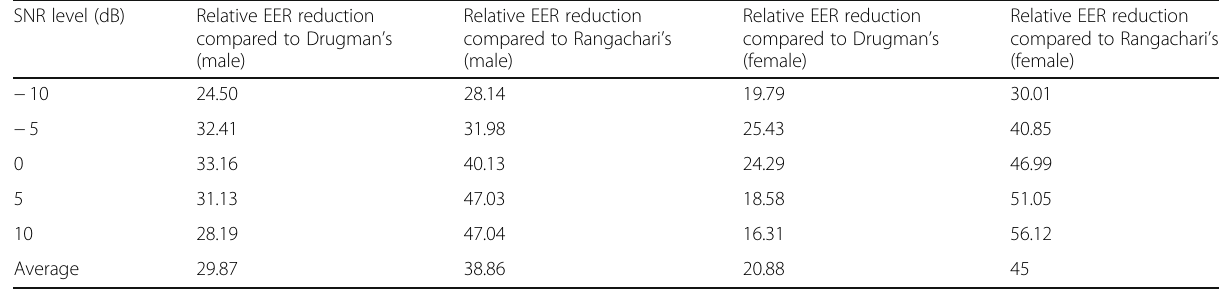
Table 7 SNR-based relative percent EER reduction rates for i-vector method compared to Drugman ’ s VAD (second and fourth column) and Rangachari ’ s method (third and fifth column). Computed by averaging over all noise